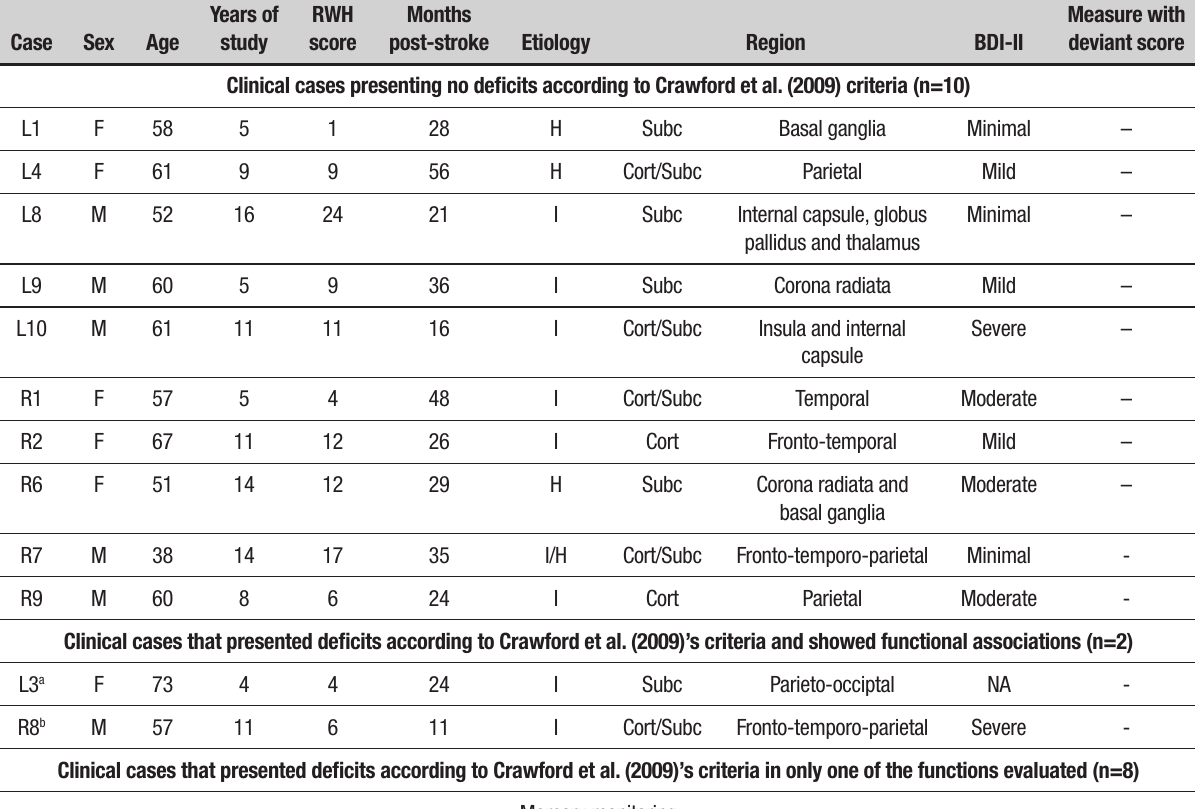
Table 2. Sociodemographic and clinical data of each case according to pattern of deficits in memory control, monitoring and capacity measures (n=20). Case